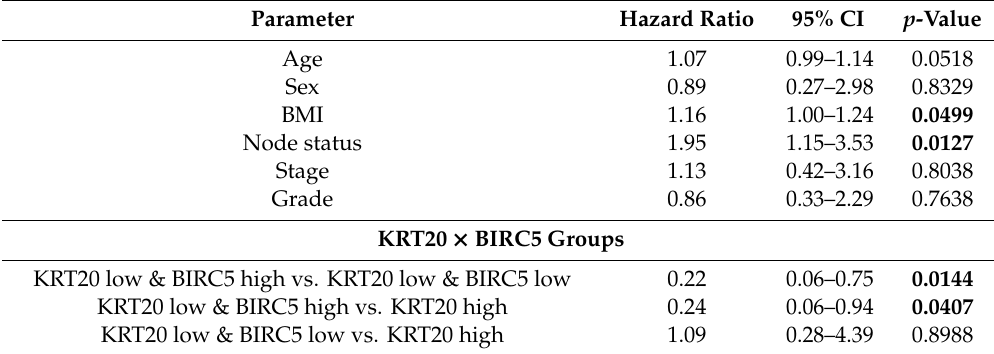
Table 3. Cox regression analysis for DSS by BIRC5 × KRT20 mRNA expression and clinicopathological features in the PCR cohort of bladder cancer patients treated with adjuvant chemotherapy. Statistically significant values are highlighted in boldface.